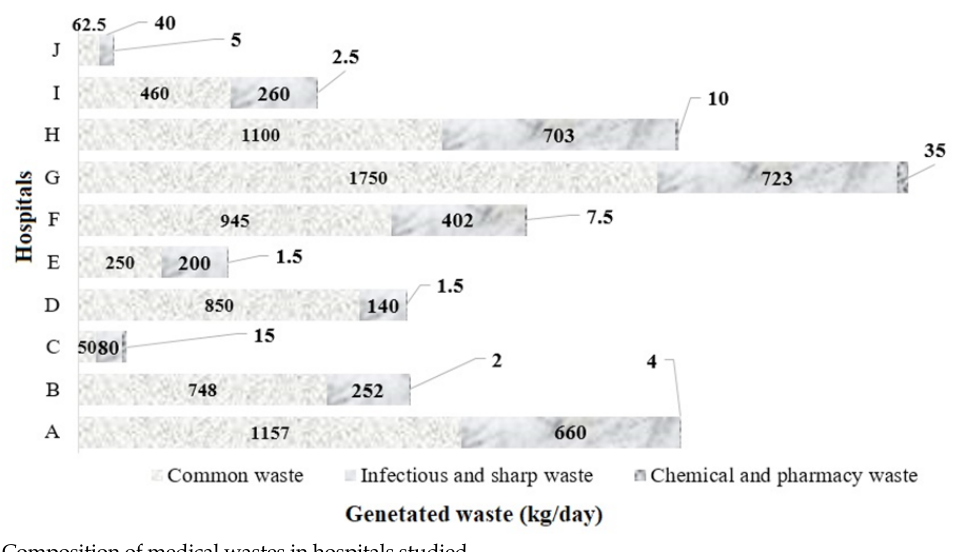
Figure 3. Composition of medical wastes in hospitals studied